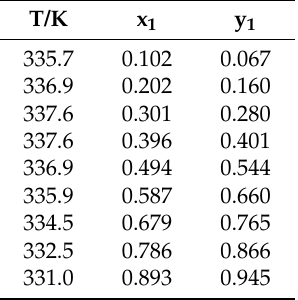
Table A2. VLE data for the ternary system of acetone (1) + chloroform (2) + [MMIM][DMP] (3) at 101.3 kPa.